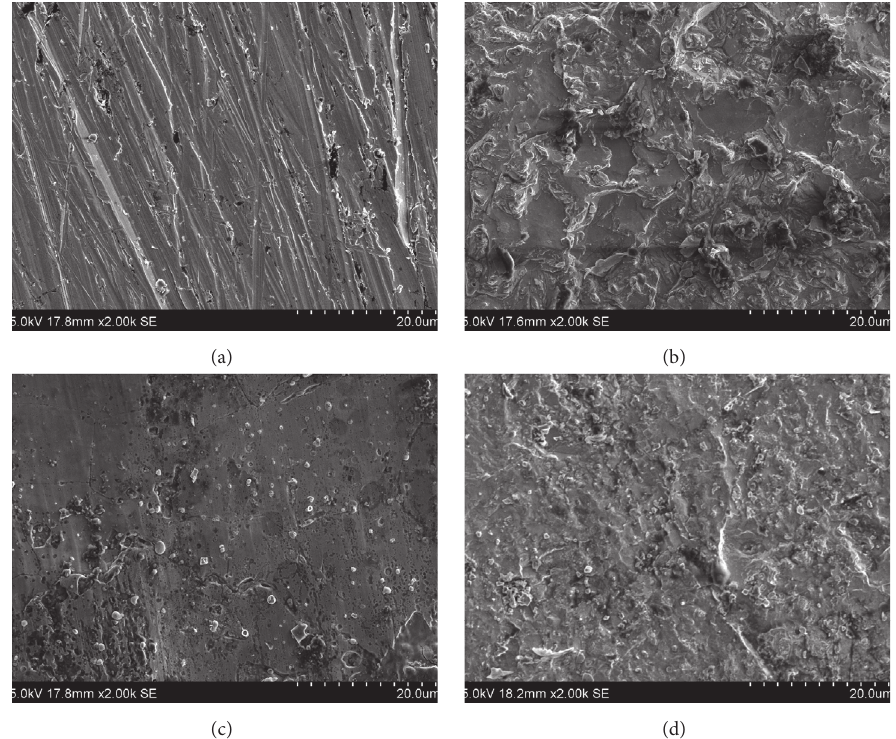
Figure 8: SEM images of (a) bare metal; (b) CS treated with 1.0 M HCl; (c) with P2APH (1.0mM); (d) with RP2APH (1.0mM) for